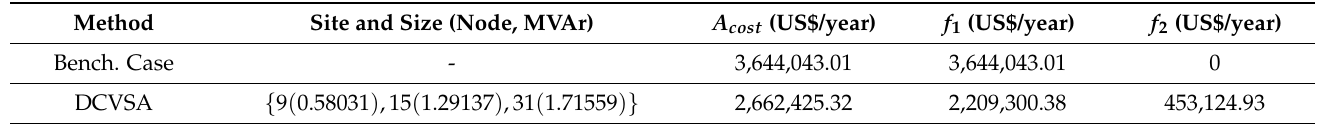
Table 6. Numerical results in the DC version of the IEEE 33-bus